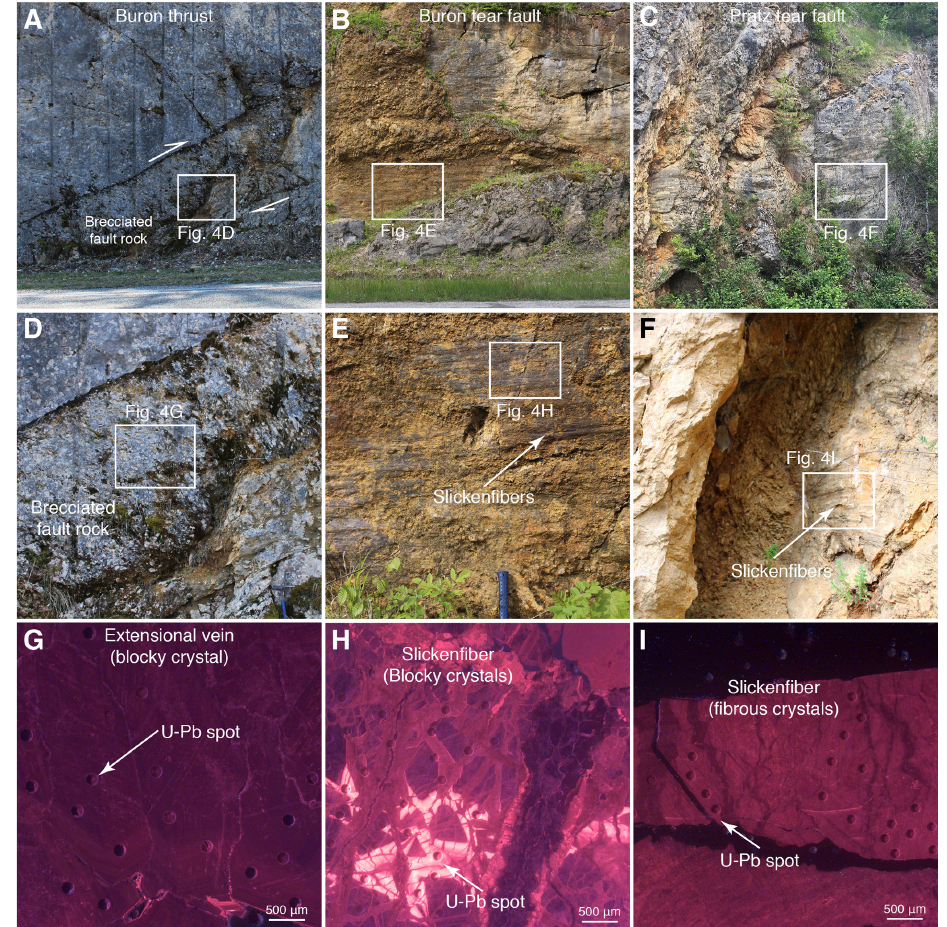
Figure 4. (a) Buron thrust. (b) Buron tear fault. (c) Pratz tear fault. (d) Brecciated fault rocks in the fault core of the Buron thrust. (e) Brecciated fault rocks cut by sharp fault planes in the fault core of the Buron tear fault. (f) Foliated fault rock cut by sharp fault planes in the fault core of the Pratz tear fault. (g–i) Cathodoluminescence microphotographs of thin sections showing extensional veins and slickenfibres from the studied faults with ablation craters of the U–Pb